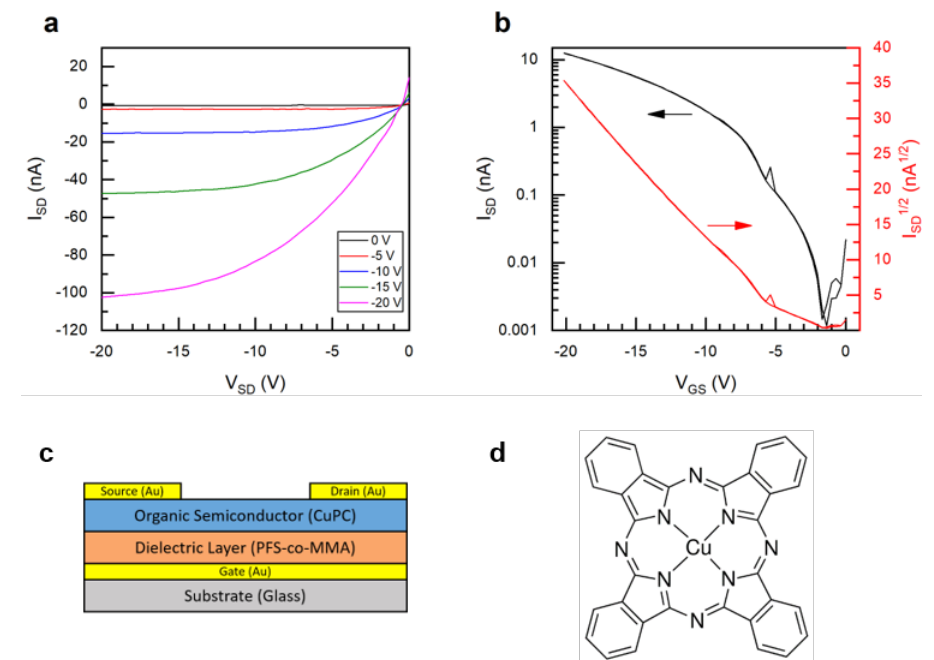
Figure 7. Characteristic ( a ) output and ( b ) transfer curves for ( c ) bottom-gate top-contact (BGTC) organic thin-film transistor (OTFT) devices with ( d ) copper phthalocyanine (CuPc) as the semiconductor (for PFS 57, VSD-20). All data for devices characterized in air. Table 4. Bottom-gate top-contact (BGTC) copper phthalocyanine (CuPc) based OTFTs fabricated using poly(PFS-ran-MMA) copolymers as the dielectric layer.